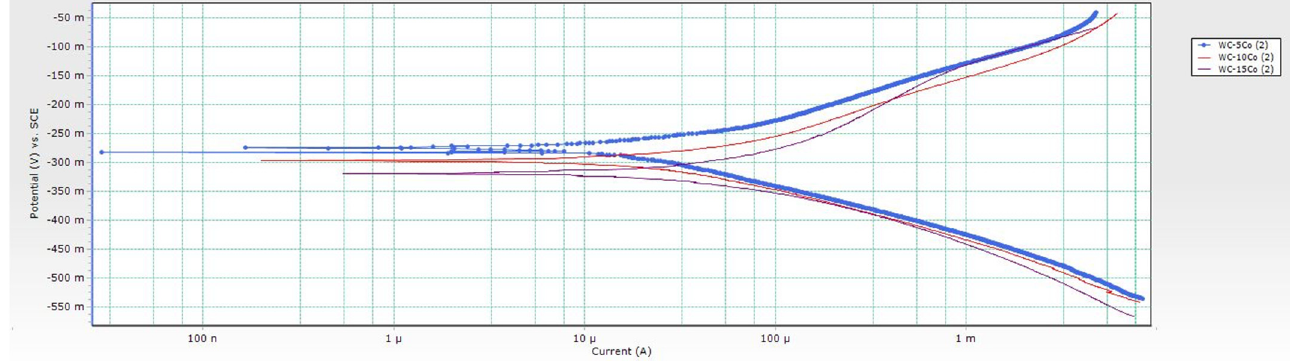
Figure 6. Tafel extrapolation curves.